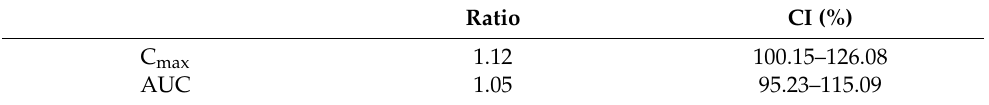
Table 2. In vivo results of the failed bioequivalence study between the test and the reference products. Ratio CI (%) C max